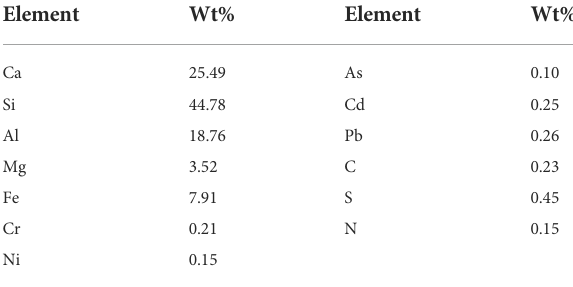
TABLE 1 Chemical composition of steel slag used in this